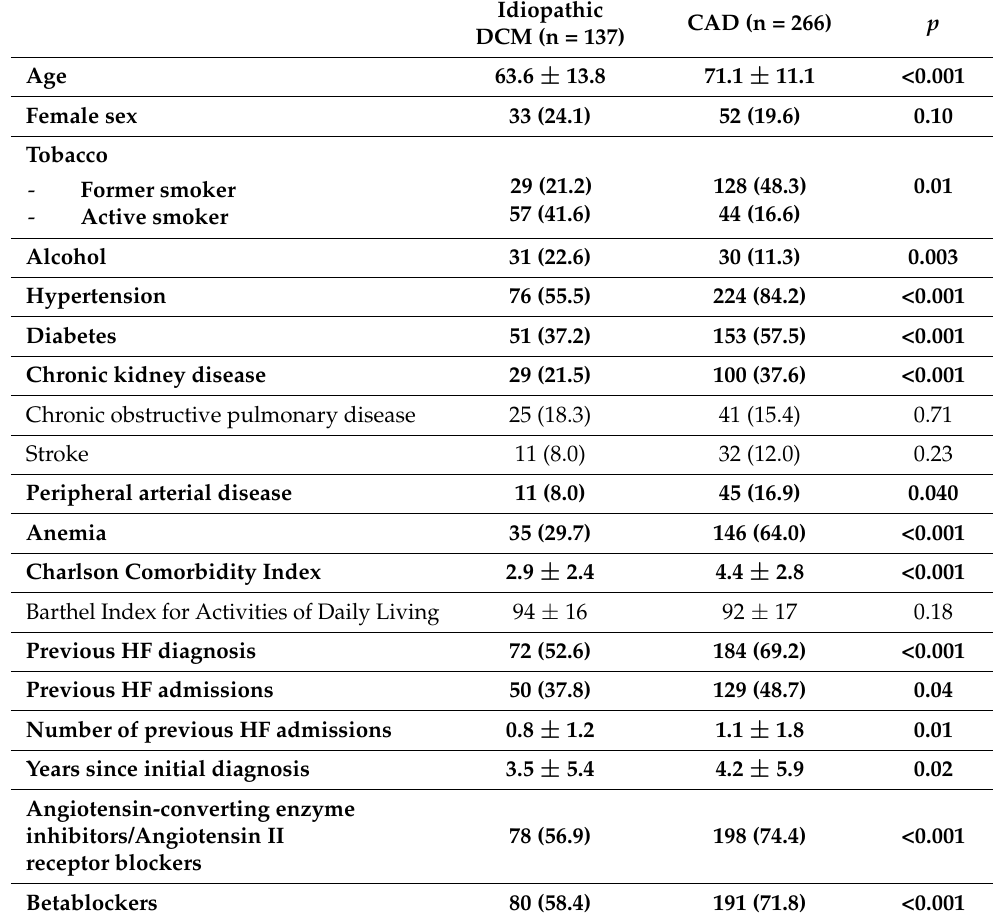
Table 1. Baseline demographic and clinical